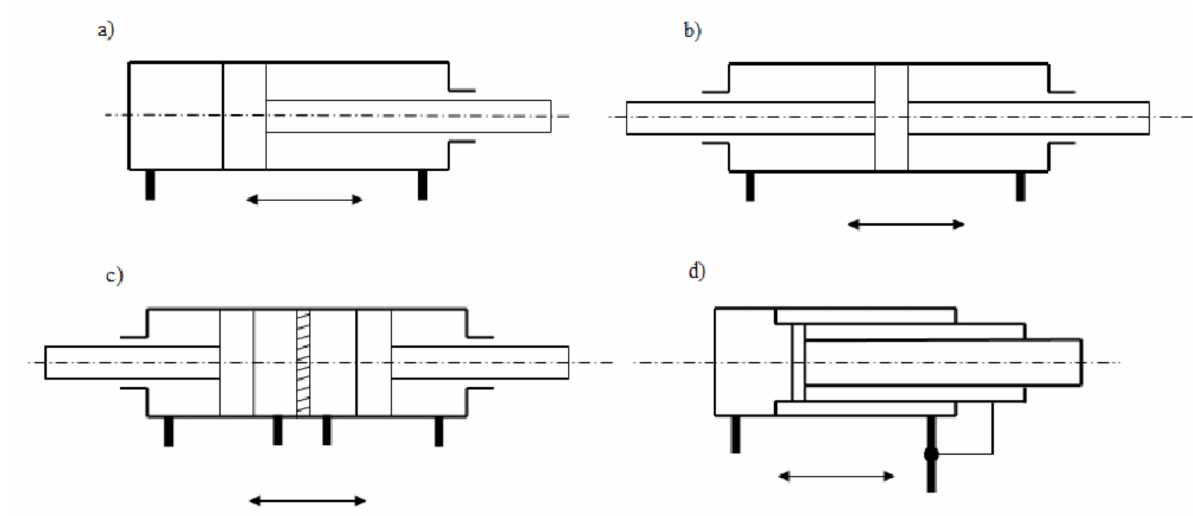
Figure 2. Types of double-acting actuators: ( a ) with one-sided piston rod, ( b ) two-sided piston rod, ( c ) multi-piston (double piston), ( d )